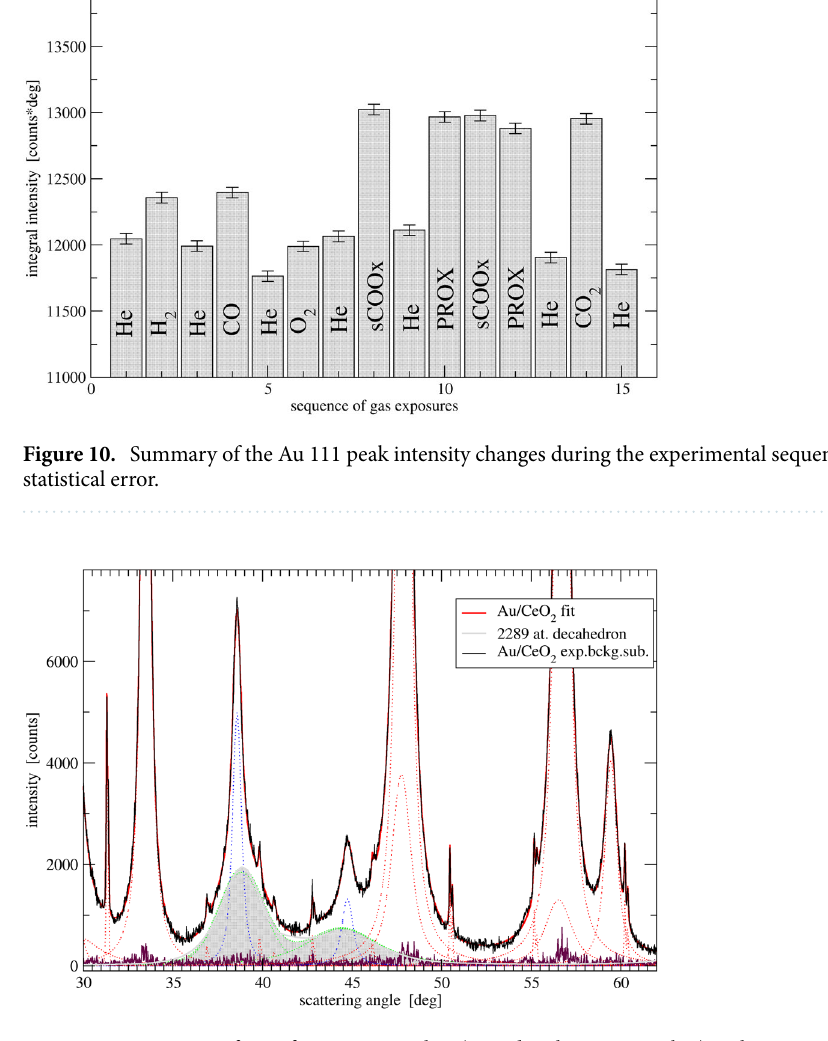
Figure 11. Fragment of DP of Au/CeO 2 catalyst (mixed with quartz marker) with ceria peaks fitted by pairs of Voigt function. Au phase could be described by pairs of peaks with broad components (grey) closely resembling calculated pattern of a model decahedron and narrower fcc-like component (dotted blue line). The noisy ‘zero line’ corresponds to error of the overall